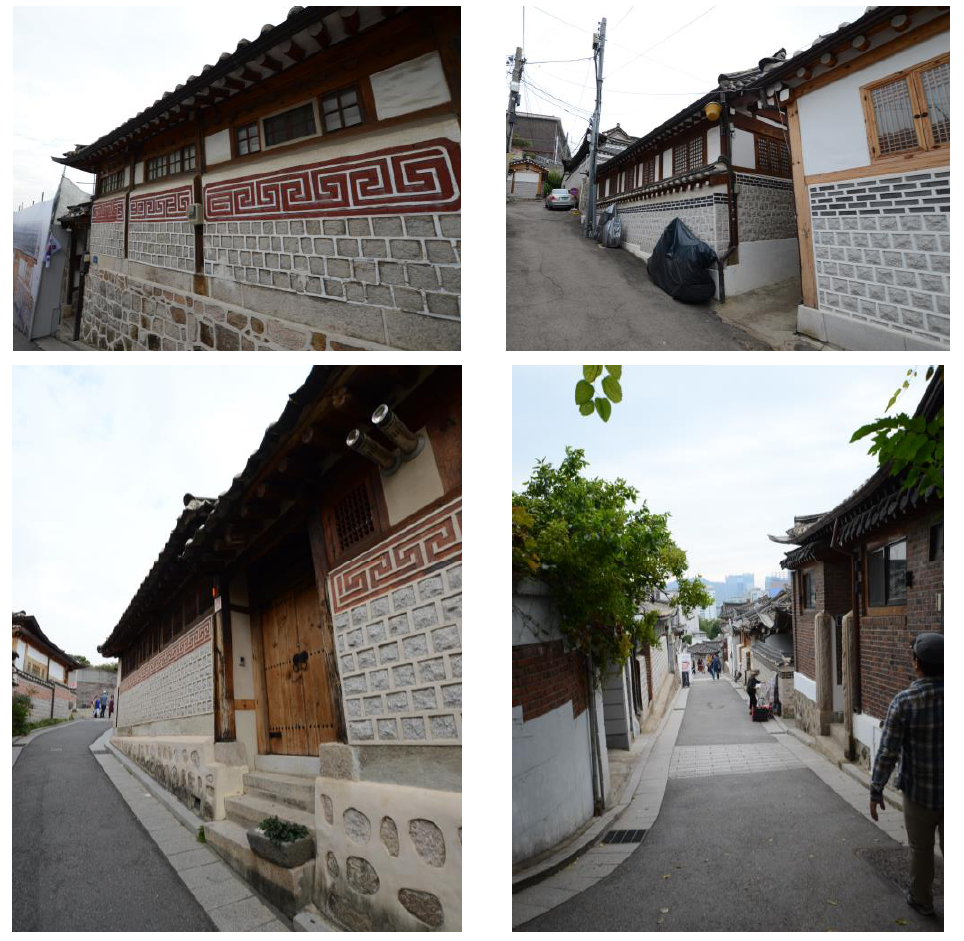
Figure 3. Streetscape and urban Hanok in the Bukchon area.